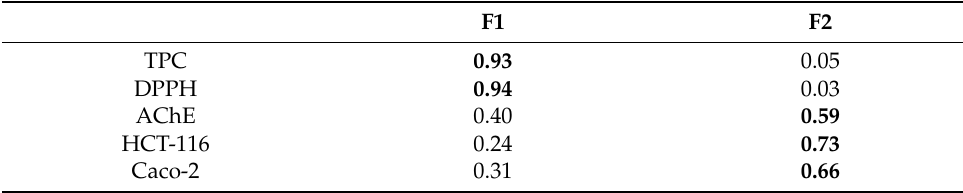
Table 6. Correlation established between variables and factors.